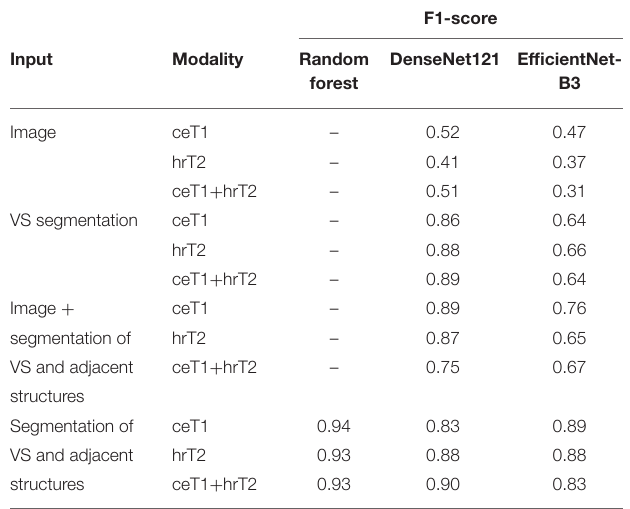
TABLE 3 | Koos classification results obtained from automatic methods and human annotators using 5-fold cross-validation.